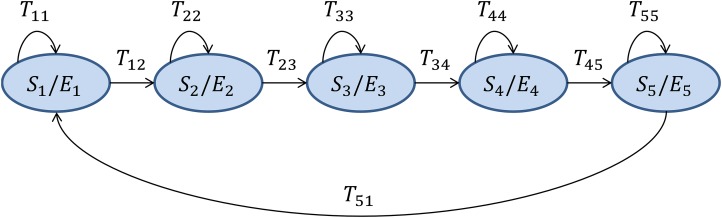
Hidden Markov Model structure for each anuran call as proposed in Rabiner (1989).